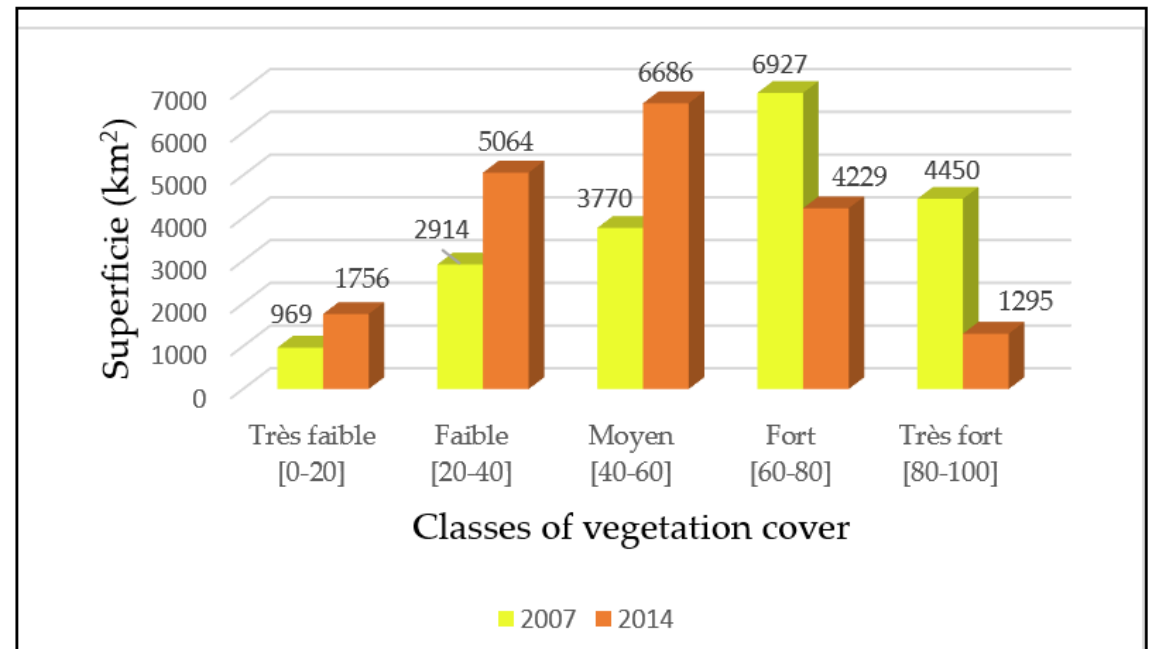
Figure 2. Evolution of vegetation cover classes between 2007 and 2014